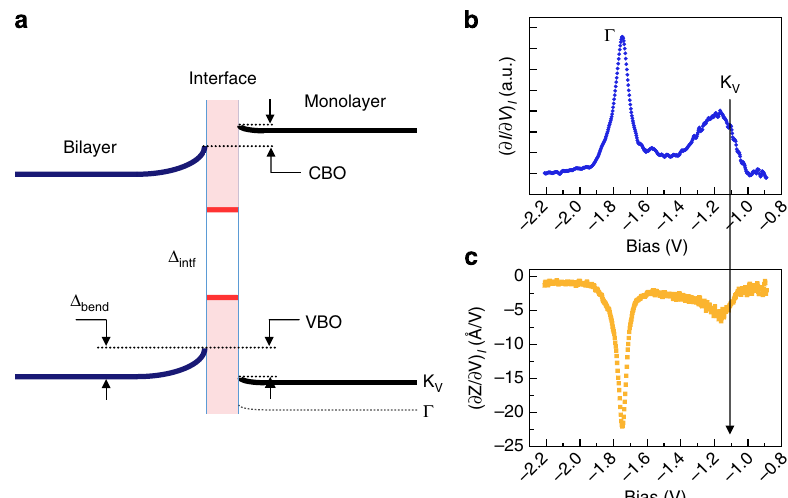
Figure 4 | Schematic diagram of band alignments and constant Z spectroscopy for valence band of ML WSe 2 . ( a ) Schematic diagram showing the generic band alignment in BL–ML TMDs HJs. The magnitude of the band bending is labelled as D bend , and the gap of interface states is D intf . ( b , c ) Two modes of constant Z spectroscopy—( q I / q V ) I and ( q Z / q V ) I for valence band of monolayer WSe 2 . The actual valence band maximum at K point is labelled as K V , which is about 0.65eV above G point. See ref. 29 for details.